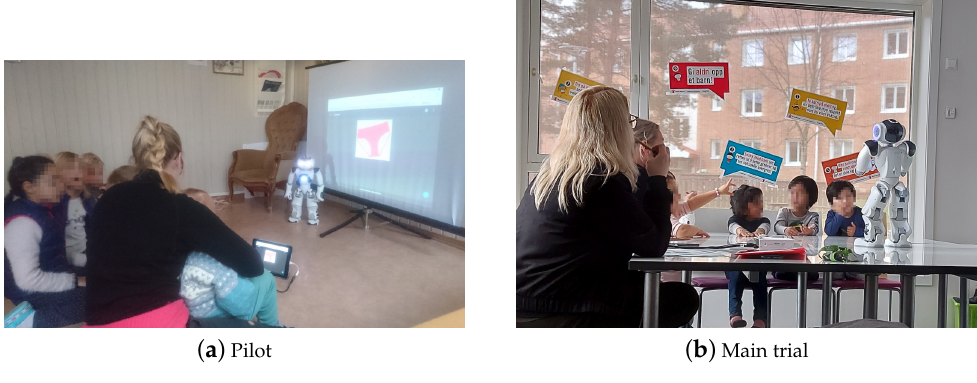
Figure 2. In situ stills from the